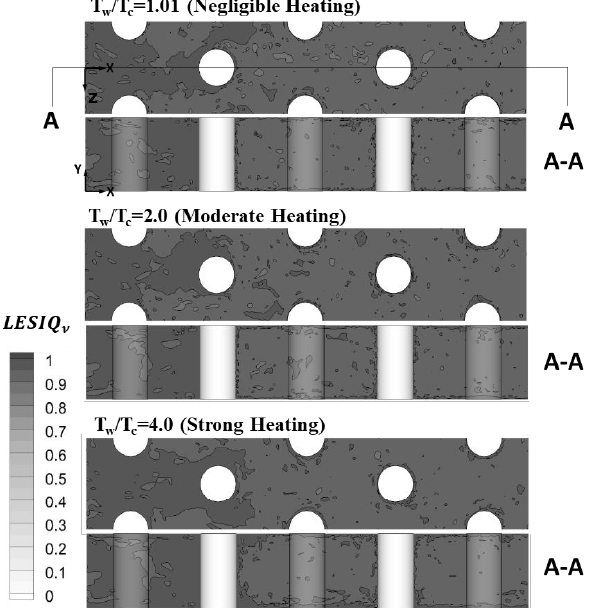
Figure 8. Celik’s index of resolution quality for the LES solutions generated.